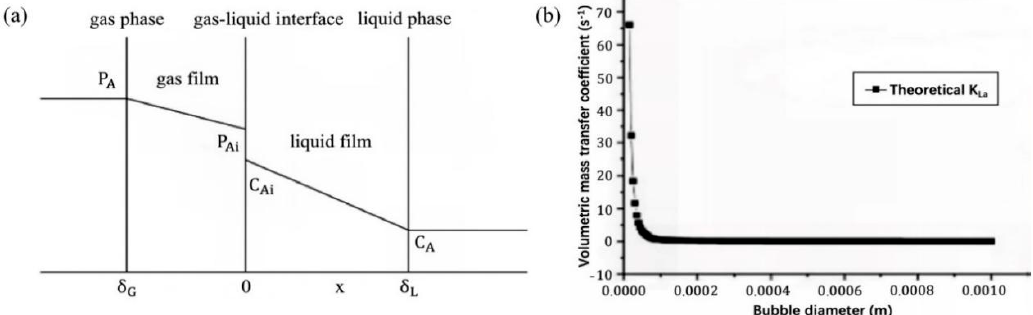
Figure 6. ( a ) A two − mode theoretical diagram of ozone mass transfer [82] and ( b ) the theoretical volumetric mass transfer coefficient values for various bubble diameters [118]. Reprinted with permission from Refs. [82,118].